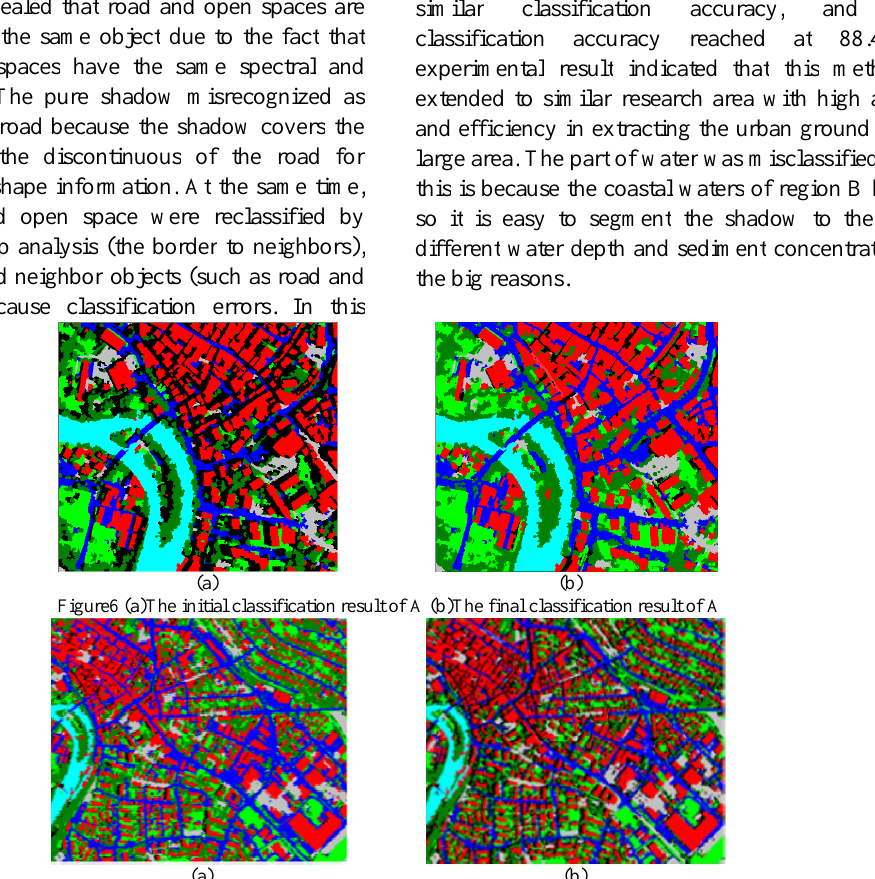
Figure7. (a)The initial classification result of B (b) The final classification result of B (the legend color is on Table 1)